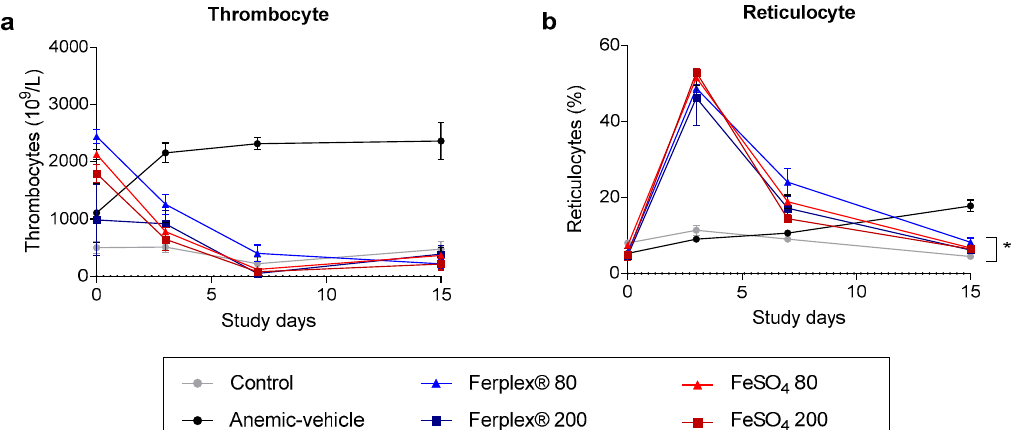
Figure 4. Cell populations affected by anemia during the treatment period. ( a ) The number of thrombocytes and ( b ) Reticulocyte percentage was recorded in blood samples on days 0, 3, and 7 and at study termination on day 15. Data are presented as mean ± SEM. There was no significant difference between treatment groups at any time point. * p < 0.05 Ferplex ® 80 mg as compared with the control group on day 15 with a Kruskal-Wallis test followed by Dunnett’s multiple comparison test. N = 5–8.